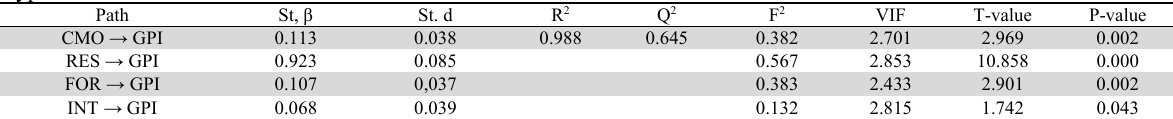
Hypothesized Direct Effects Structural